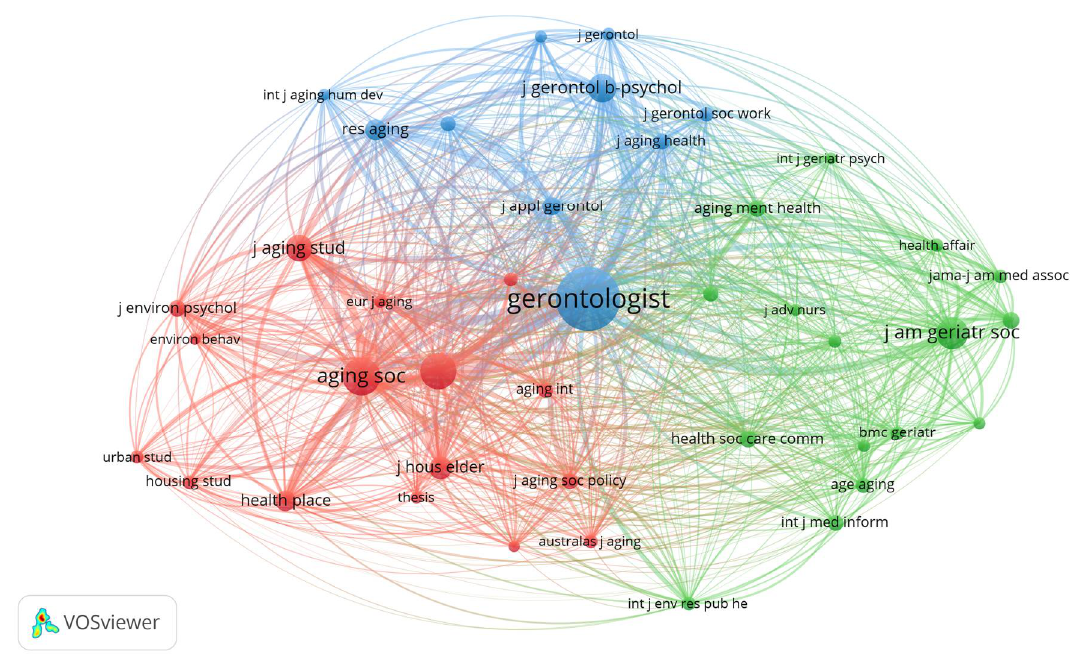
Figure 7. Network visualization of journal